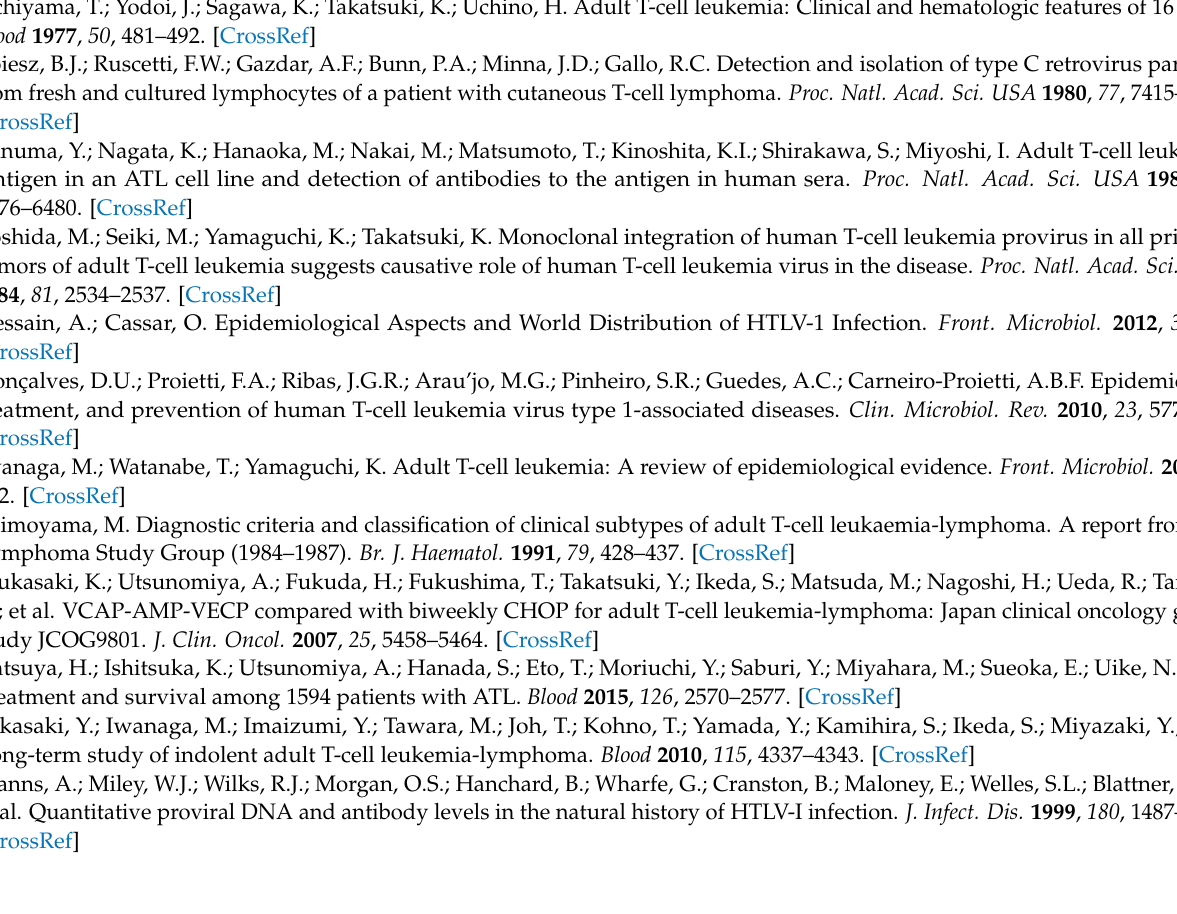
various stimuli; Table S1. Antibody binding competition assay; Table S2. Mutual correlation